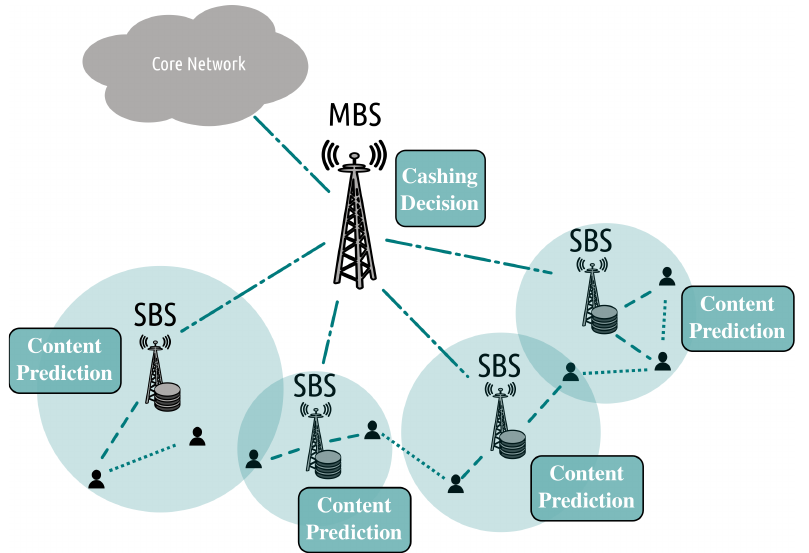
Figure 7. Intelligent caching network. Machine learning is used for content prediction and deciding which content to cache in each SBS and from where to deliver it to the users. Decisions can be centralized at the MBS or distributed at the SBS or follow federated learning